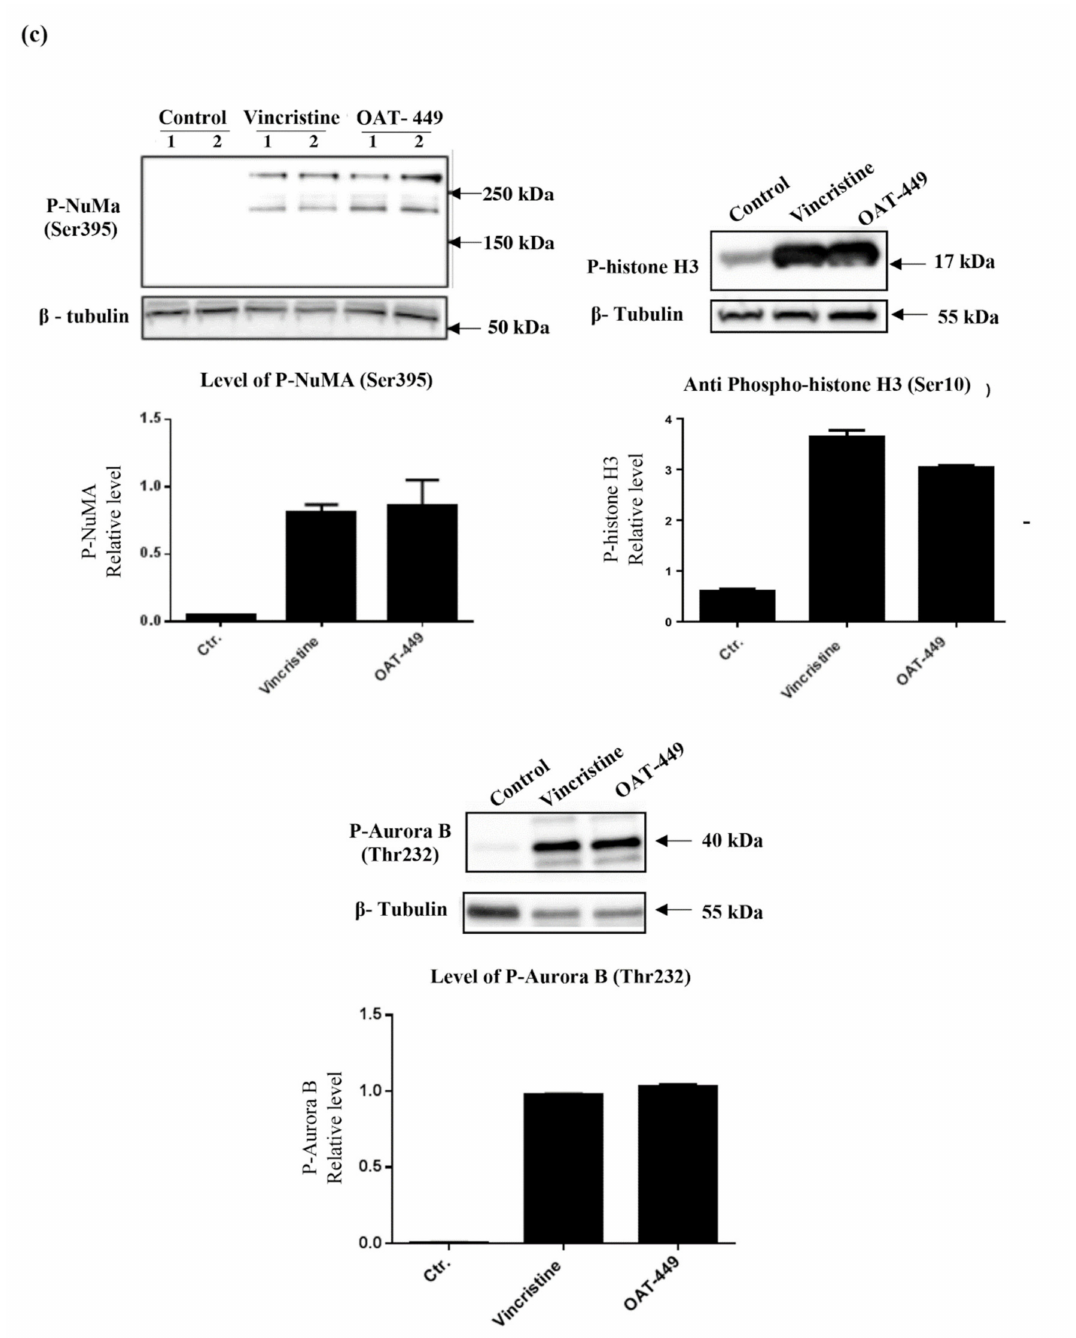
Figure 7. Both OAT-449 and vincristine modify phosphorylation of histone H3, Aurora B, and NuMa with increasing exposure time. HT-29 cells were treated with 30 nM OAT-449 or vincristine for the indicated times. The expression of P-histone H3 (Ser10), P-AuroraB (Thr232) and P-NuMa (Ser395) was determined by immunoblotting. ( a ) E ff ect of OAT-449 or vincristine on histone H3 phosphorylation in HT-29 cells after treatment for 1 h-18 h. ( b ) E ff ect of OAT-449 or vincristine on Aurora B phosphorylation in HT-29 cells after treatment for 1 h-18 h. ( c ) E ff ect of OAT-449 or vincristine on NuMa, histone H3 and Aurora B phosphorylation in HT-29 cells after treatment for 18 h (Lanes 1–2 represent biological replicatesforeachexperimentalcondition). Densitometryofimmunoblotdatarepresentssignalintensity relatively to β -tubulin (mean ± SEM). Data are representative of 3 or more independent